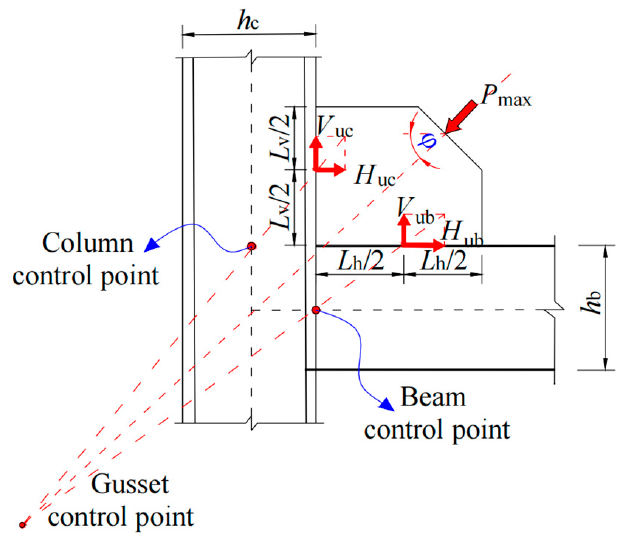
Figure 3. GUFM [24].